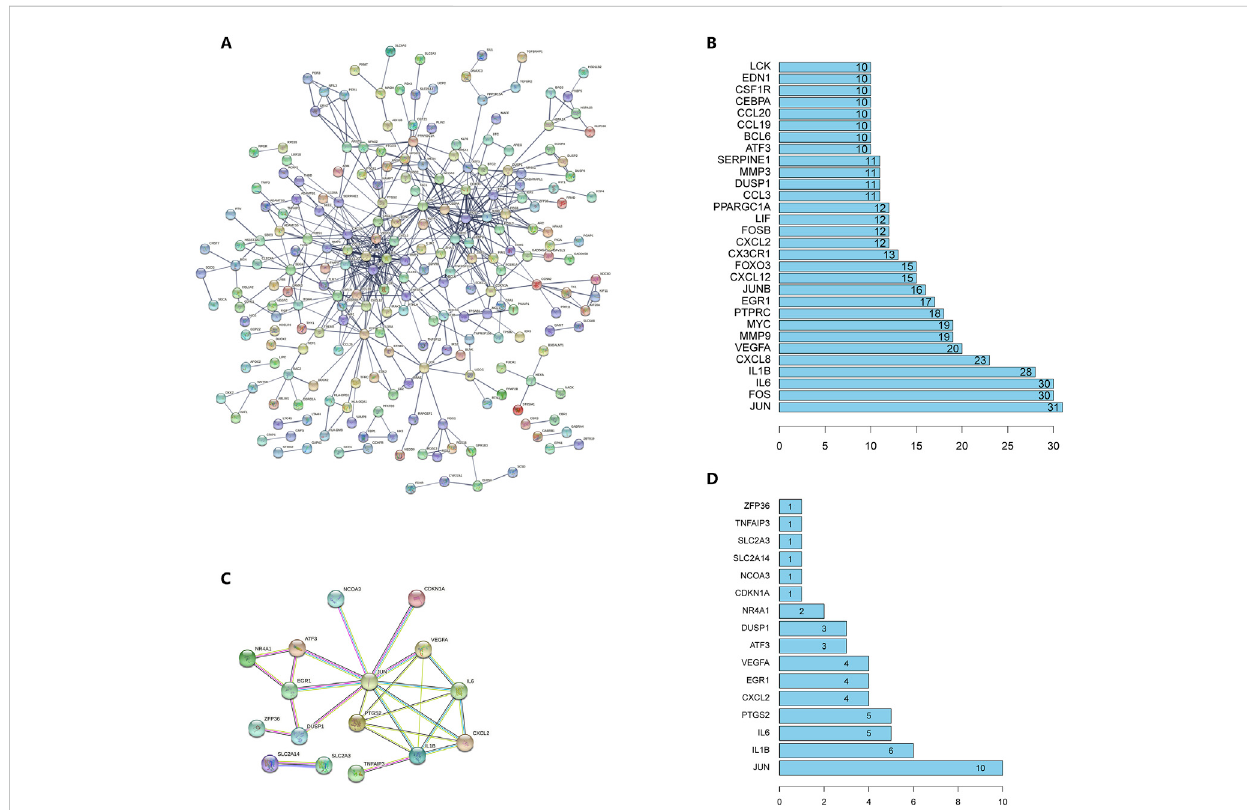
FIGURE 4 (A) PPI network of DEGs. A node represents a protein and an edge represents an interaction between two proteins. For node content, empty nodes represent proteins of unknown 3D structure and fi lled nodes represent proteins with known or predicted 3D structure. (B) The number of interactions of top 30 proteins with each other. (C) PPI network of DFGs. Different edge colors represent different types of associations. (D) The number of interactions of all differentially-expressed ferroptosis-related proteins with each